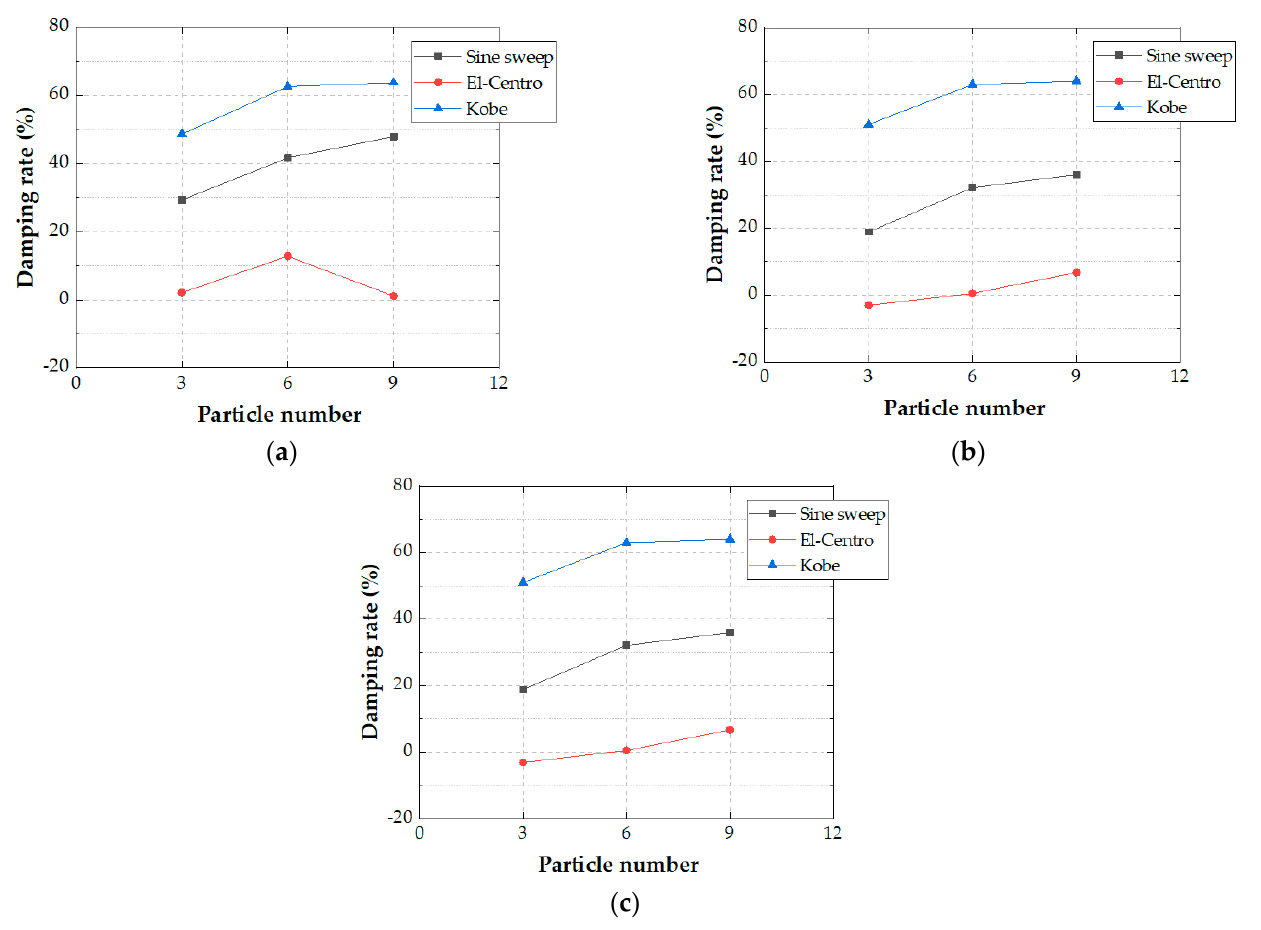
Figure 4. Vibration damping rate of acceleration value (root mean square) under different mass ratios: ( a ) 1%; ( b ) 2%; ( c ) 3%.